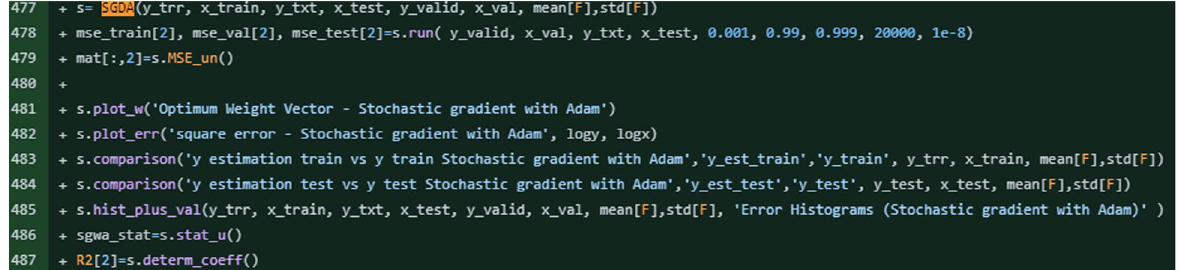
Fig. 17 Represents the part of the code, complete code is accessible at